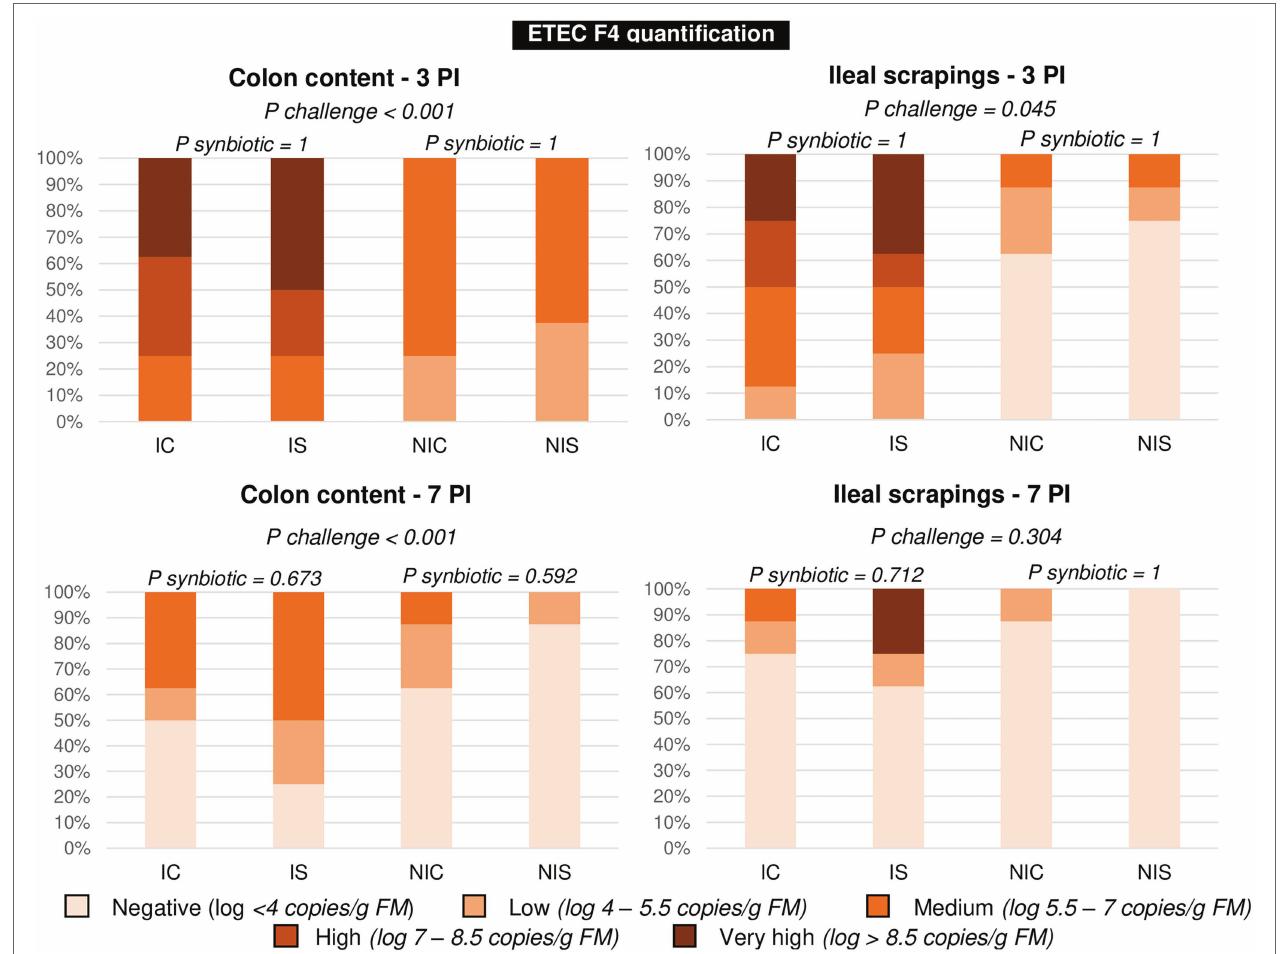
FIGURE 3 | Percentage of animals in each presence level of ETEC F4 on days 3 and 7 post-inoculation. Different animals were sampled on day 3 PI (medium weight) and 7 PI (greatest weight). IC, inoculated animals receiving placebo; IS, Inoculated animals receiving the synbiotic; NIC, Non-inoculated animals receiving placebo; and NIS, Non-inoculated animals receiving the synbiotic. N = 8 for all experimental groups. Values of p were obtained using Fisher’s Exact Test on R